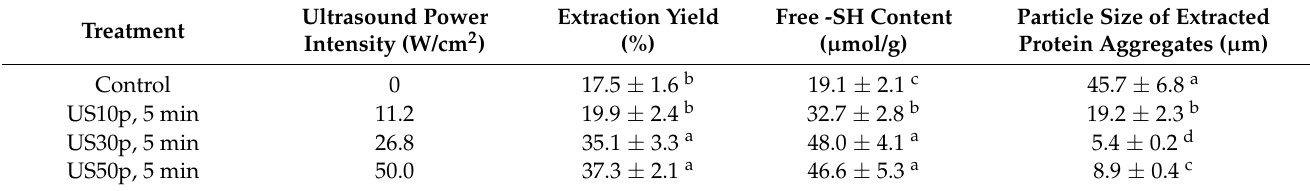
Table 3. The impact of ultrasonic power (after 5 min sonication) on the protein extraction yield, particle size, and free -SH content of